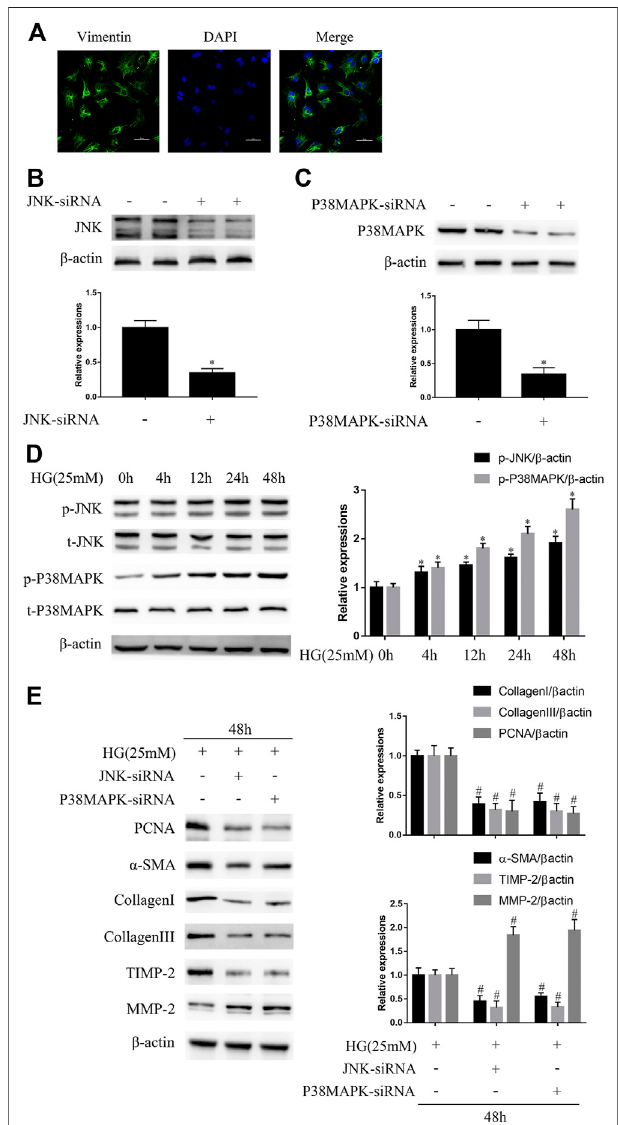
FIGURE 1 | JNK and p38 MAPK mediate high glucose (HG)-induced fi brogenic protein upregulation in vitro (A) NRCFs were con fi rmed by vimentin andDAPIstaining(originalmagni fi cation × 400).Scalebars,50 μ m.Datawere obtained from three independent experiments (B and C) NRCFs transfected with or without JNK or p38 MAPK siRNA were evaluated for the protein expression of JNK and p38 MAPK by western blotting (D) NRCFs were exposed to HG for 0 – 48 h and JNK/p38 MAPK phosphorylation and total JNK/p38 MAPK expression were determined by western blotting (E) NRCFs were transfected with or without JNK/p38 MAPK siRNA and then exposed to HG for the indicated periods of time. The protein expression of PCNA, α -SMA, TIMP2, collagen I, collagen III, and MMP2 was determined by westernblotting.Datain (B – E) arepresentedasmean ± SEM( n (cid:2) 3). p -values in (B – D) were calculated using paired Student ’ s t -test. p -value in (E) was calculated using one-way ANOVA with Tukey multiple comparison test. * p < 0.05, compared to the normal group; # p < 0.05, compared to the HG